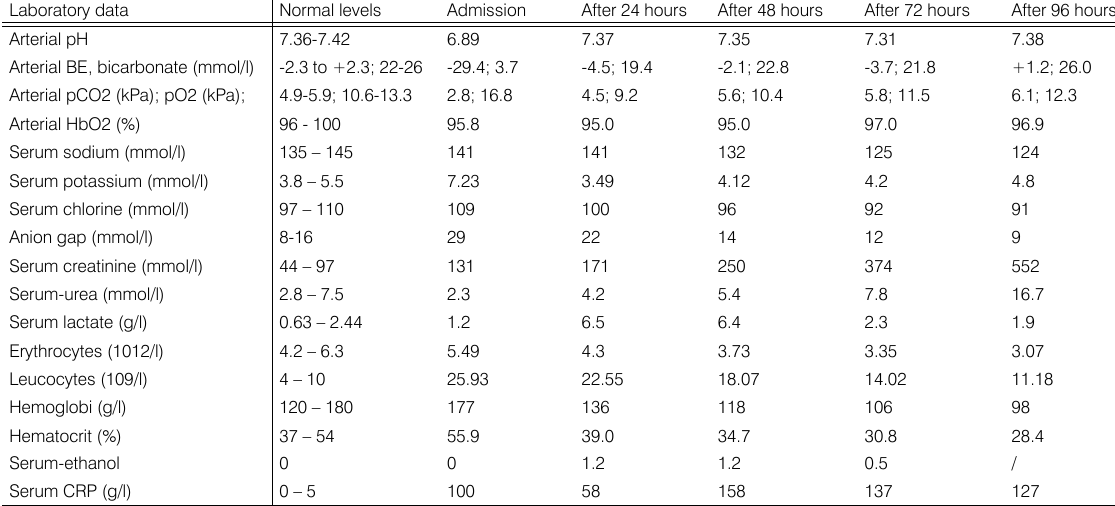
Table 1. Laboratory data on admission and during first 96 hours Laboratory